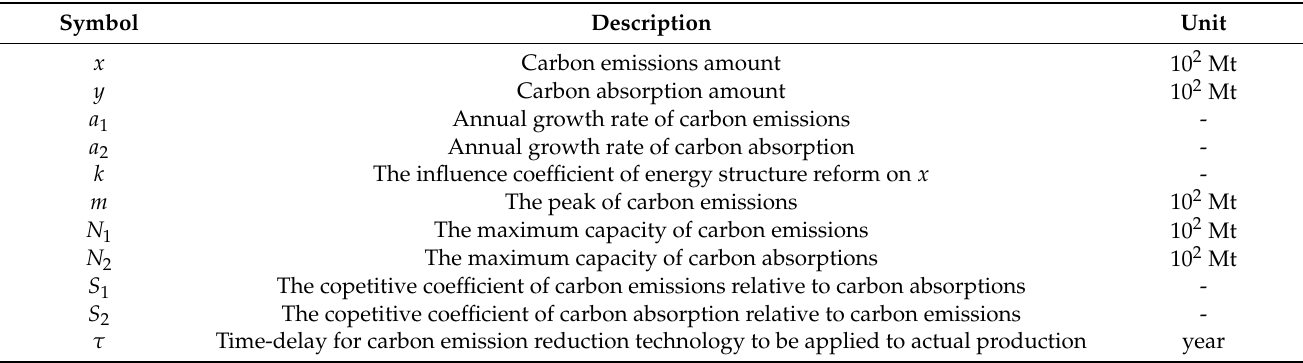
Table 1. Descriptions of variables and parameters in the model